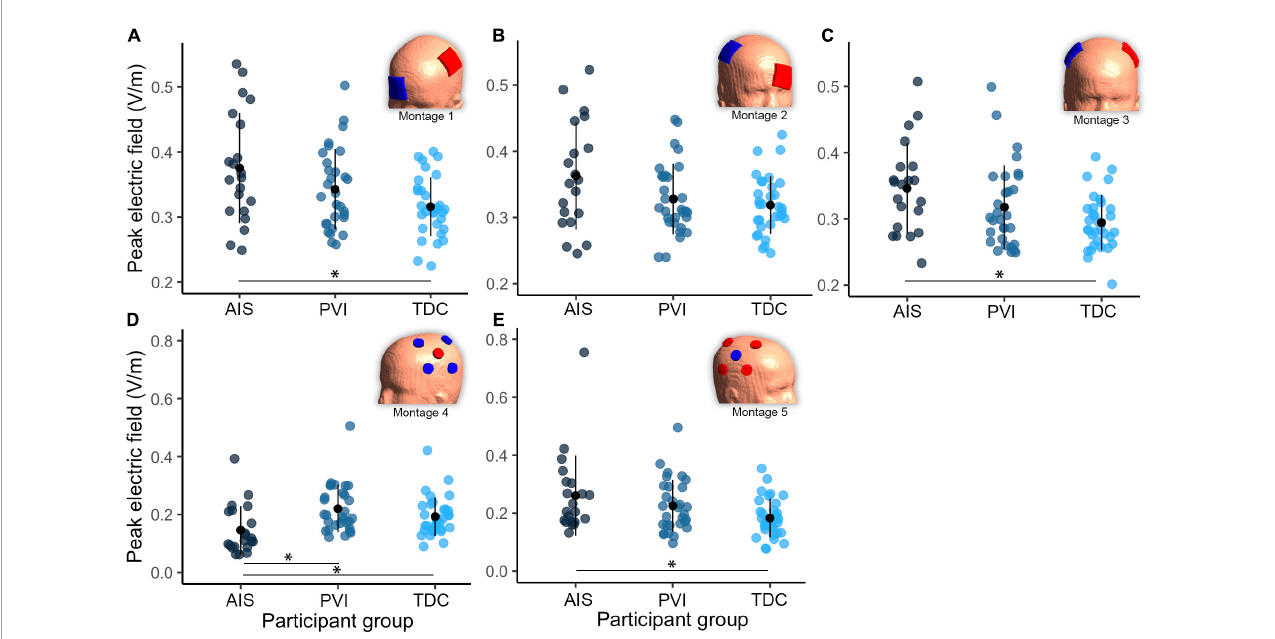
FIGURE4 Group differences in peak electric field (EF) within gray matter between three participant groups and five transcranial direct-current stimulation (tDCS) montages (A–E) . Note that the EF strength scales are different between montages 1–3 and montages 4–5. Montage diagrams illustrate electrode configuration for a child with a left hemisphere stroke. AIS, arterial ischemic stroke; PVI, periventricular venous infarction; TDC, typically developing control. Horizontal lines denote significant pairwise contrasts (* p FDR < 0.01), vertical lines denote ± 1 standard deviation. Red electrodes denote anode locations, blue electrodes denote cathode